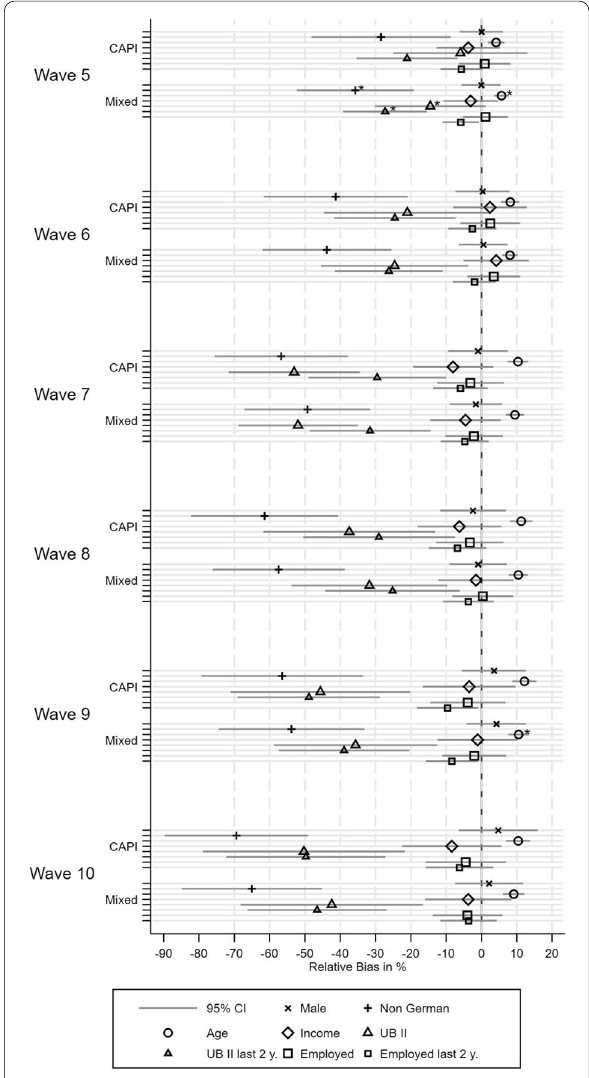
Fig. 3 Relative Total Bias Wave 5–10. Data: Panel Study Labour Market and Social Security (PASS) PASS_0618_v1, sample 6 Waves 5–10 & PASS paradata, Waves 5–10 & IAB Integrierte Erwerbsbiografien (IEB) V13.00.00. * Difference between CAPI and mixed-mode within a = wave is statistically significant at 5%